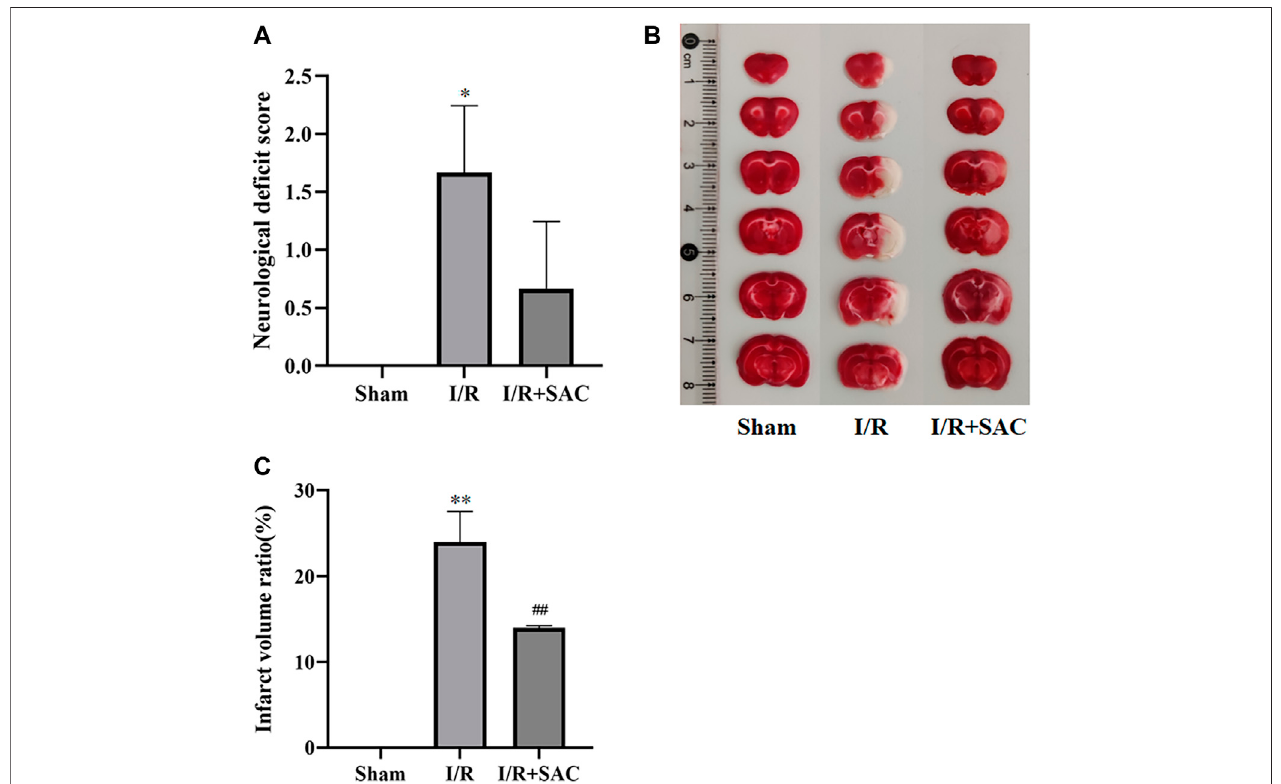
FIGURE 8 | Neurological de fi cit score of rats in each group after 7 days of SAC treatment (A) . Representative photographs (B) and statistical results (C) of brain tissue in rats. * p < 0.05, ** p < 0.01, vs the sham group. # p < 0.05, ## p < 0.01, vs the I/R group (n = 3).